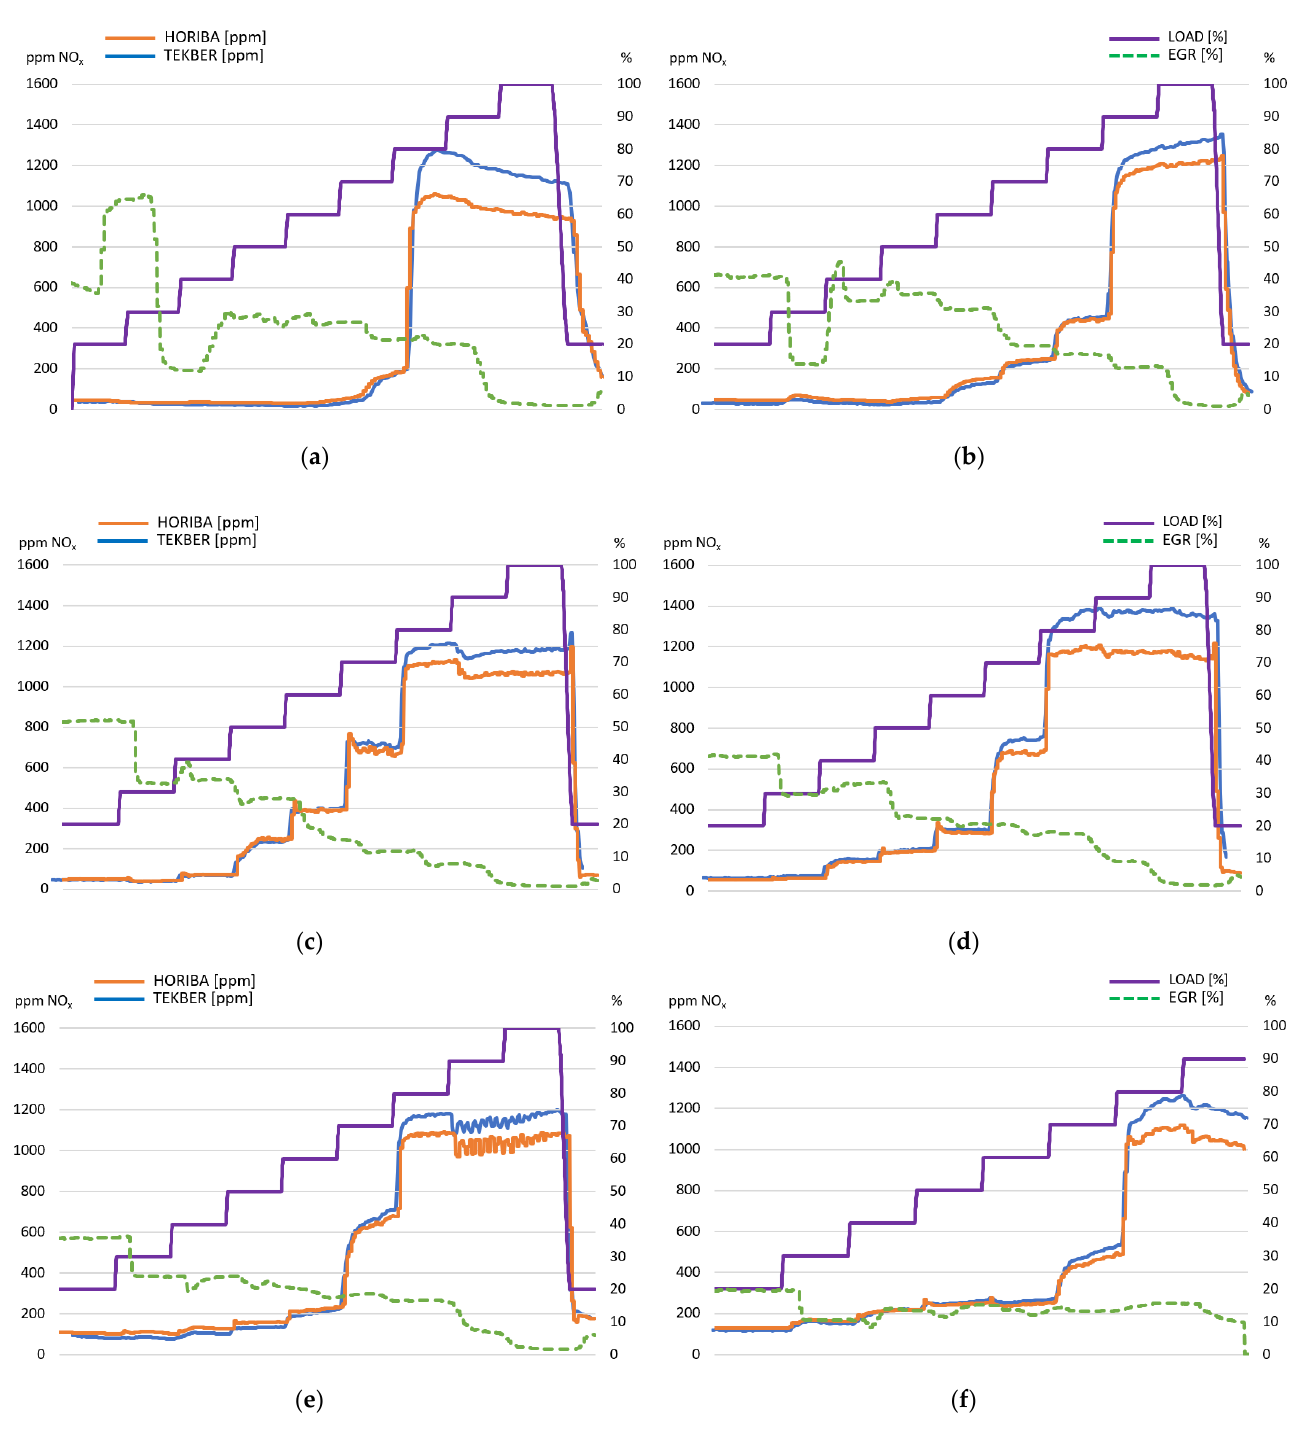
Figure 6. NO x concentration with EGR activated: ( a ) @800 rpm, ( b ) @1000 rpm, ( c ) @1500 rpm, ( d )